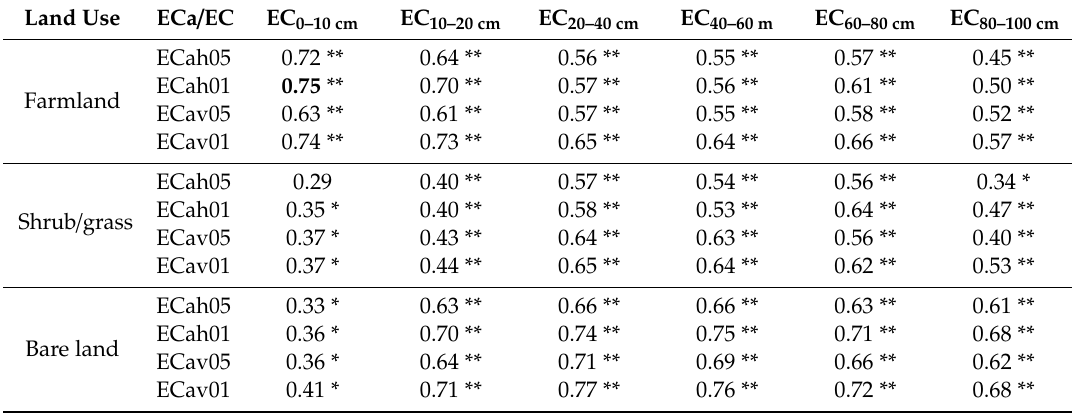
Table 4. Pearson’s correlation coe ffi cient between ECa and EC at di ff erent depths and land use